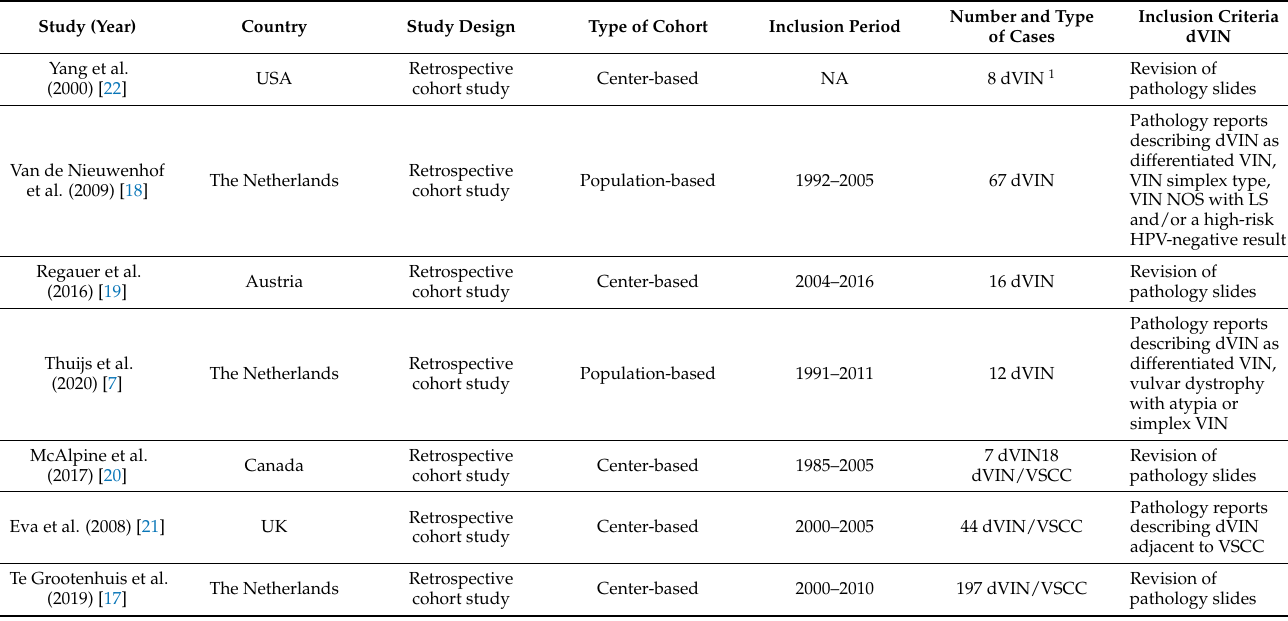
Table 1. Characteristics of included studies.